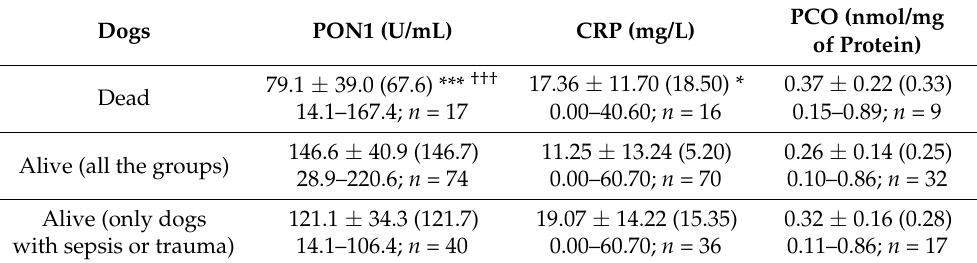
Table 3. Mean ± SD, median (between parenthesis) and min-max range of PCO, CRP and PON1 in dogs that died and dogs that survived, both including and excluding clinically healthy dogs.